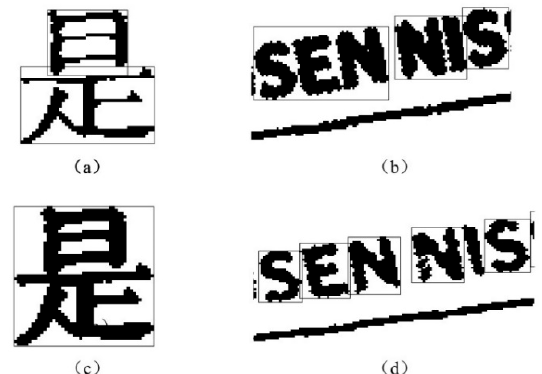
Figure 2. The morphological operation: ( a ) the original Chinese character with two CCs; ( b ) the original English word; ( c ) the Chinese character after dilation operation; ( d ) the English word with erode operation.